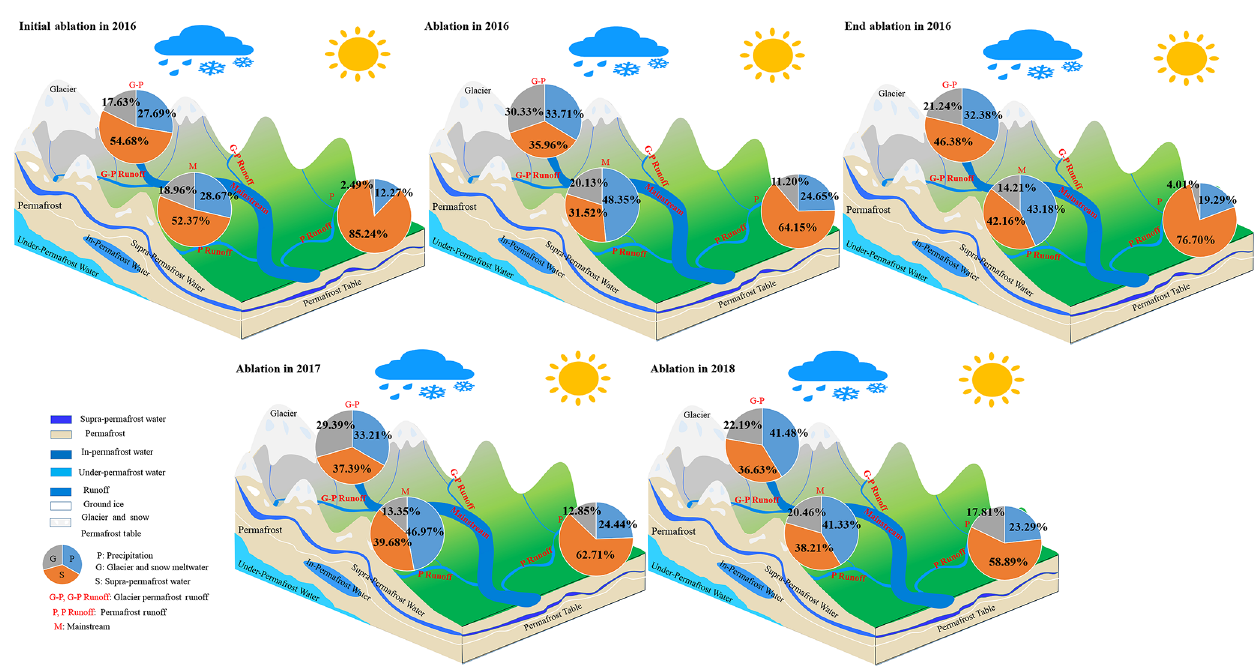
Figure 11. Conceptual model map of the recharge form and proportion of the river water in different ablation periods. (Dark green represents the basin of river in permafrost area; gray and light green represent the basin of the river in glacier permafrost area.)